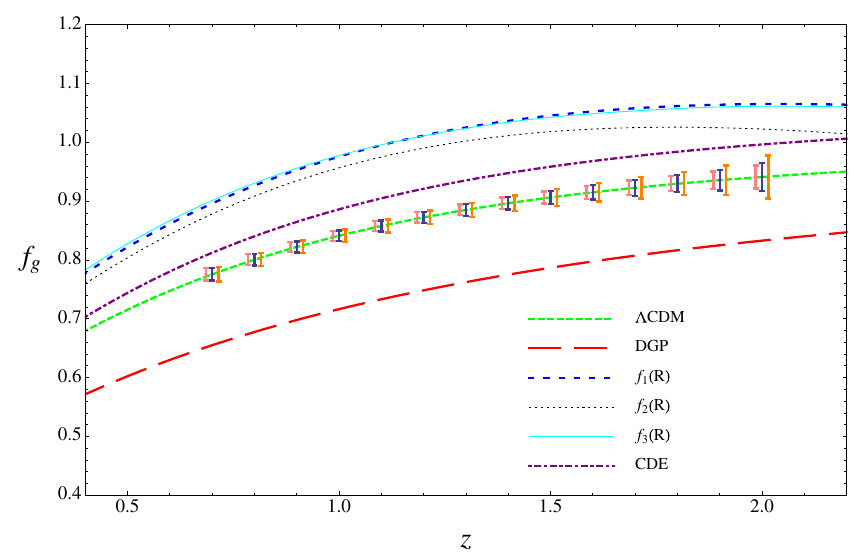
Fig. 19 Expected constraints on the growth rates in each redshift bin. For each z the central error bars refer to the Reference case while those referring to the Optimistic and Pessimistic case have been shifted by − 0 . 015 and + 0 . 015 respectively. The growth rates for different models are also plotted: Λ CDM (green tight shortdashed curve), flat DGP (red longdashed curve) and a model with coupling between dark energy and dark matter (purple, dot-dashed curve). Here we plot again the f ( R ) model by Hu and Sawicki (2007a), Eq.(I.5.36),with n = 2 and μ = 3(blueshortdashedcurve)togetherwiththemodelbyStarobinsky(2007), Eq. (I.5.37), with n = 2 and μ = 3 (cyan solid curve) and the one by Tsujikawa (2008), Eq. (I.5.38), with μ = 1 (black dotted curve). Also in this case it will be possible to distinguish these models with